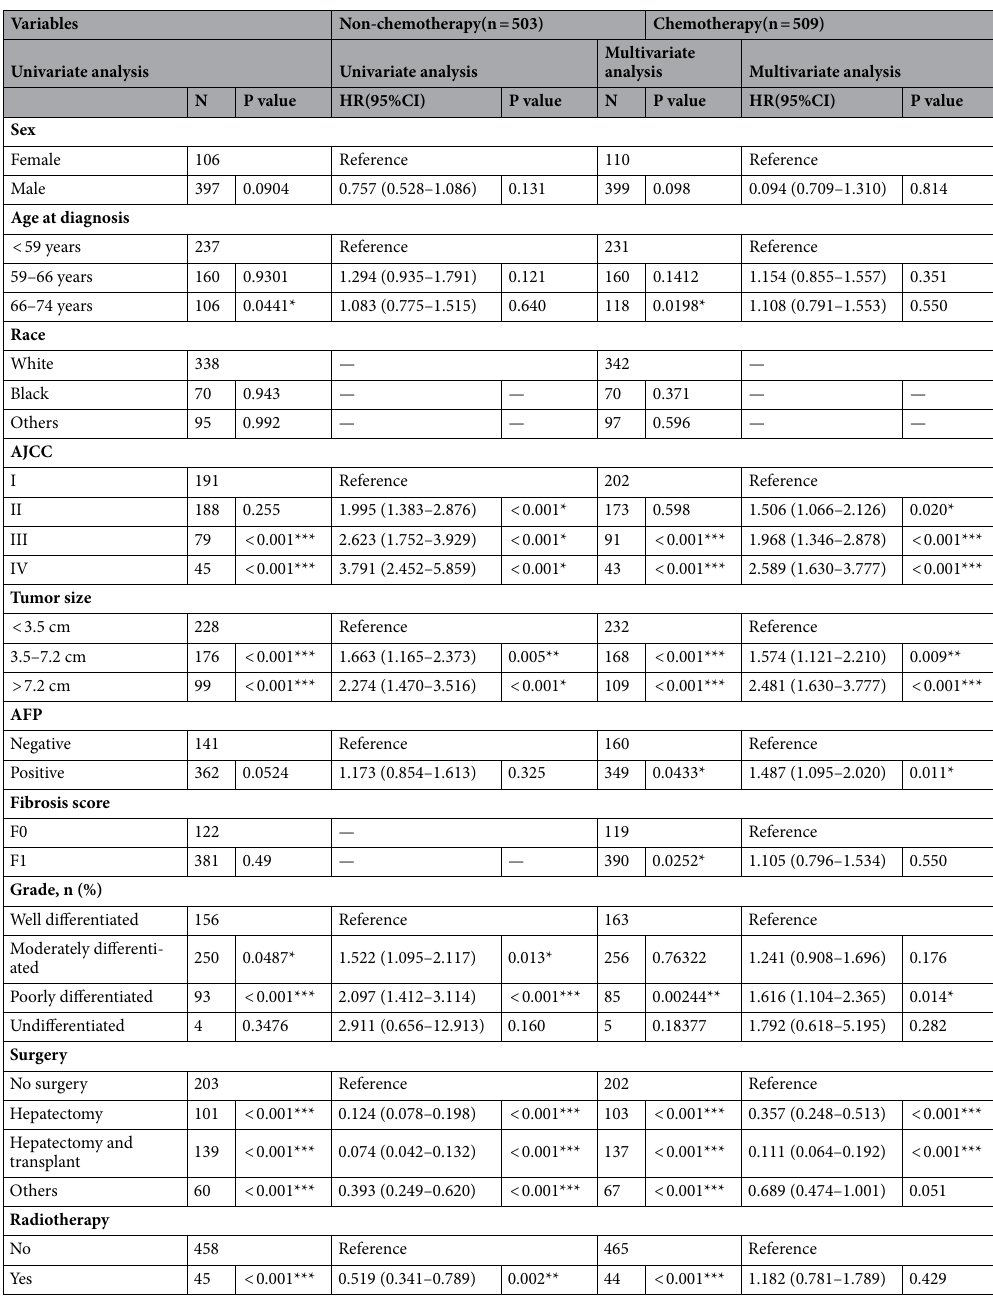
Table 3. Univariate and multivariate analysis of CSS in the patients with chemotherapy and without chemotherapy. *Two-sided P values < 0.05. **Two-sided P values < 0.01. ***Two-sided P values < 0.001. CSS, cancer-specific survival; HR, hazard ratio; CI, coindidence intervals; AJCC, American Joint Committee on Cancer (7th). F0, fibrosis score 0–4, non to moderate fibrosis; F1, fibrosis score 5–6, severe fibrosis and